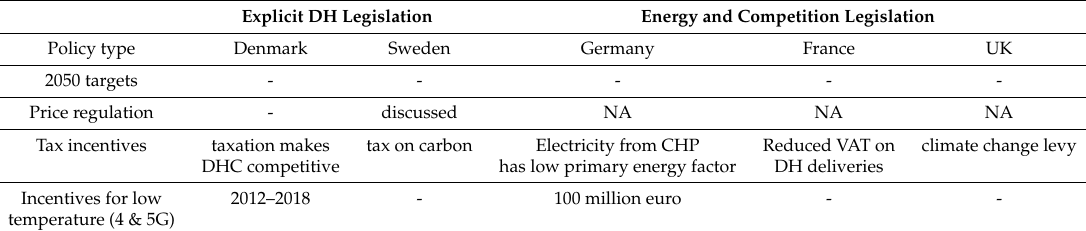
Table 1. Lessons learned from frameworks in five